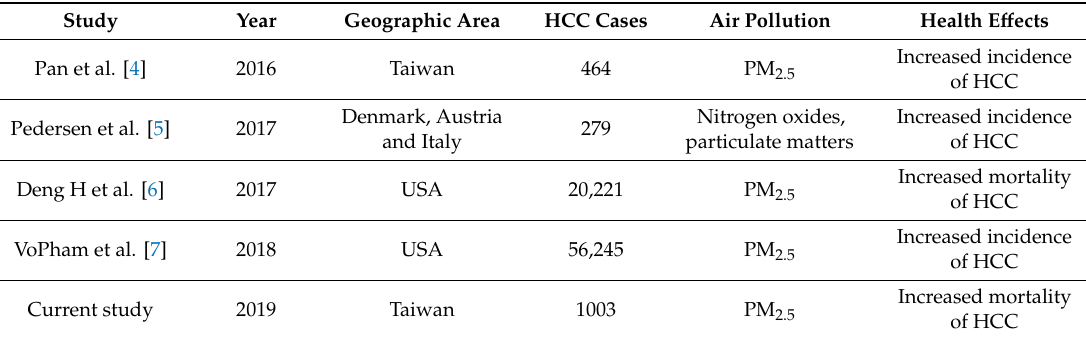
Table 1. Published studies of the health e ff ects of particulate matter air pollution on patients with